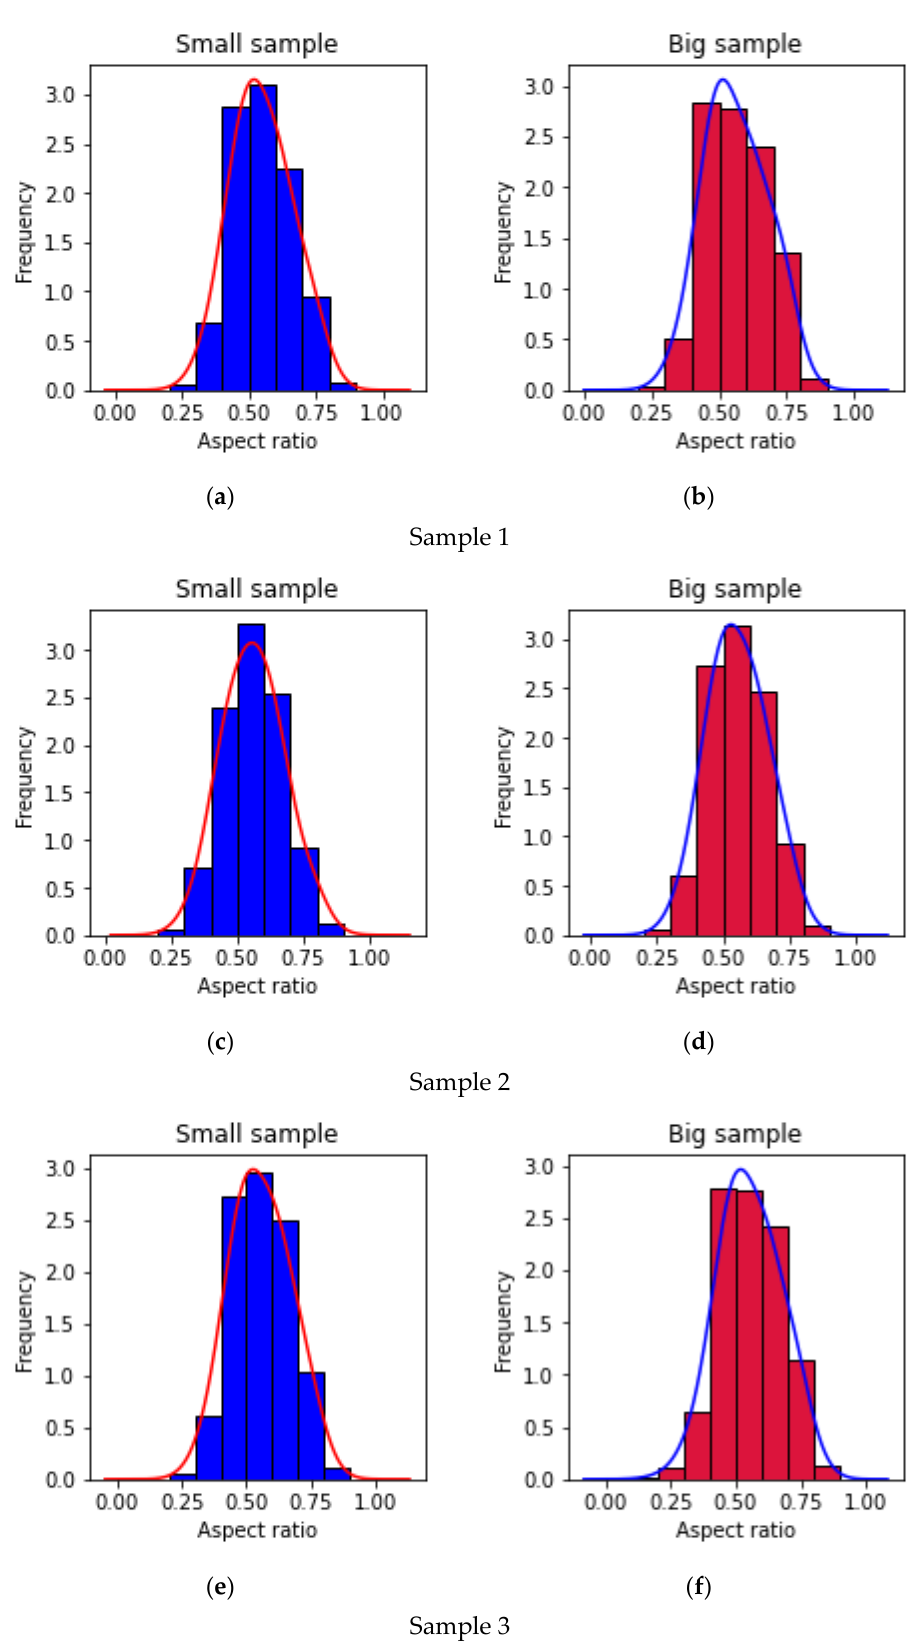
Figure 4. Histograms and PDFs of pore’s aspect ratio for small samples ( left ) and big samples ( right ): ( a ) and ( b ) for Sample 1; ( c ) and ( d ) for Sample 2; ( e ) and ( f ) for Sample 3.